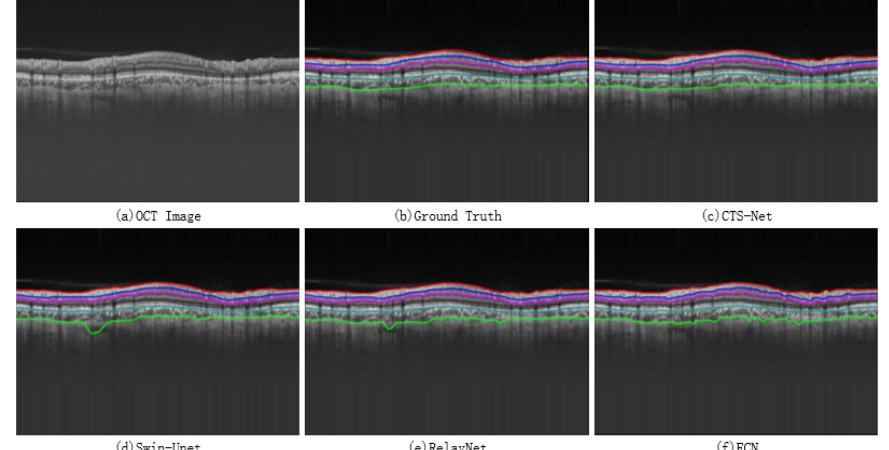
Figure 7. Retinal layer boundary results obtained by four methods.